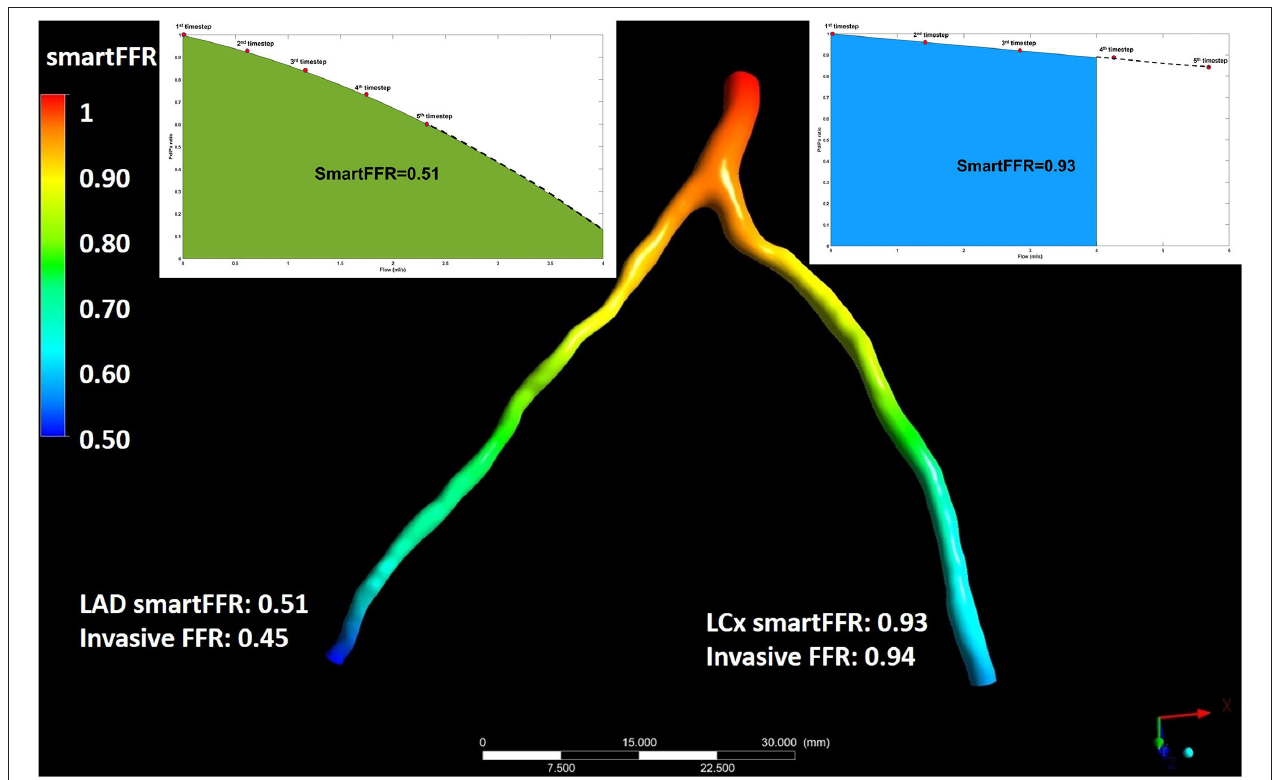
FIGURE 4 | Illustration depicting the simultaneous SmartFFR calculation process for the two main branches of the left coronary vasculature (i.e. LAD and LCx). The dashed line after the last simulation timestep at the LAD branch was used to extrapolate the curve to reach the 4 ml/s mark, whereas for the LCx branch, the curve was interpolated to limit the curve to the 4 ml/s mark,